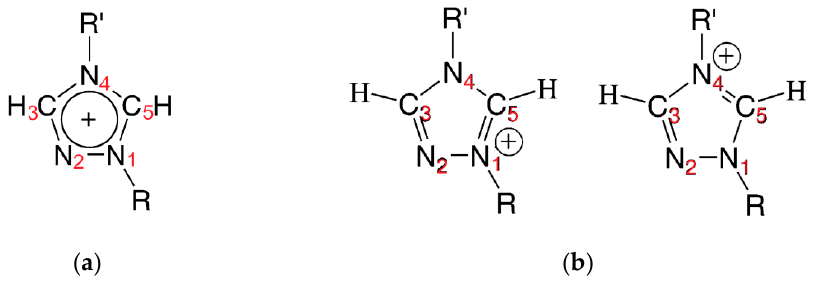
12 of 25 ( c ) Figure 4. Results of FTIR investigations: shifts in the absorption bands of the ( a ) C3-H ( ∆𝜈 𝐶3-𝐻 ) and ( b ) C5-H ( ∆𝜈 𝐶5-𝐻 ) bonds of 1,2,4-triazole ring of the ionic liquids and ( c ) SH ( ∆𝜈 𝑆𝐻 ) group of the thiols PETMP (filled symbols) and PETMB (open symbols) in four-component systems (thiol–ene–IL–PC). Synthesized triazolium ionic liquids have an amphiphilic character, which means that they possess hydrophobic alkyl chains as substituents and a hydrophilic triazole ring. These ionic liquids can be classified on the basis of the Walden plots as “good” ionic liquids, which means that they exhibit poor cation–anion interactions, which are common for ILs with large organic cations, as well as large and/or noncoordinating anions [34]. However, in the case of triazolium ILs, the cation–anion coordination is stronger than in imidazolium ILs due to the increased acidity of the triazolium ring (more acidic C5 hydrogen) [13,34]. The shifts in absorption bands C3-H and C5-H of the triazole ring differ from each other and are higher for the C5-H bands (except ionic liquid with [MMT] + cation). This is due to the more acidic proton of carbon C5 and the structure of the ring which is presented in Figure 5a. As can be seen, the carbon C3 is connected with nitrogen atoms N2 and N4, and the second has an alkyl chain as a substituent. Carbon C5 is connected to nitrogen atoms N1 and N4, and both have an alkyl chain substituent. Furthermore, the resonance structures of this cation (Figure 5b) are the same, and the positive charge is divided equally between nitrogen N1 and N4 [35]. Thus, hydrogen connected to carbon C5 can interact with monomers (their carbonyl group) more strongly than hydrogen connected to the carbon C3. The shifts in these two bands decreased slightly with increasing alkyl chain length of the substituents of studied ILs. As can be seen, for C3-H bands, they are in the range of 2.72–3.64 cm − 1 , and for C5-H, they are in the